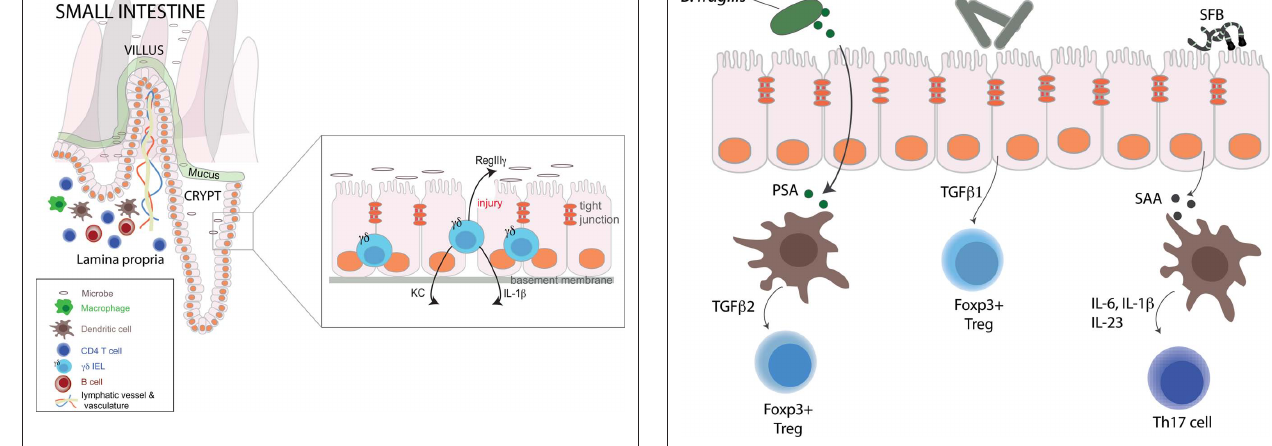
Figure 2 | immunomodulatory members of the gut microbiota that regulate lamina propria CD4 T cell subsets. Bacteroides fragilis , segmented filamentous bacteria, and Clostridium spp. are depicted along with the mechanisms by which they influence lamina propria CD4 T